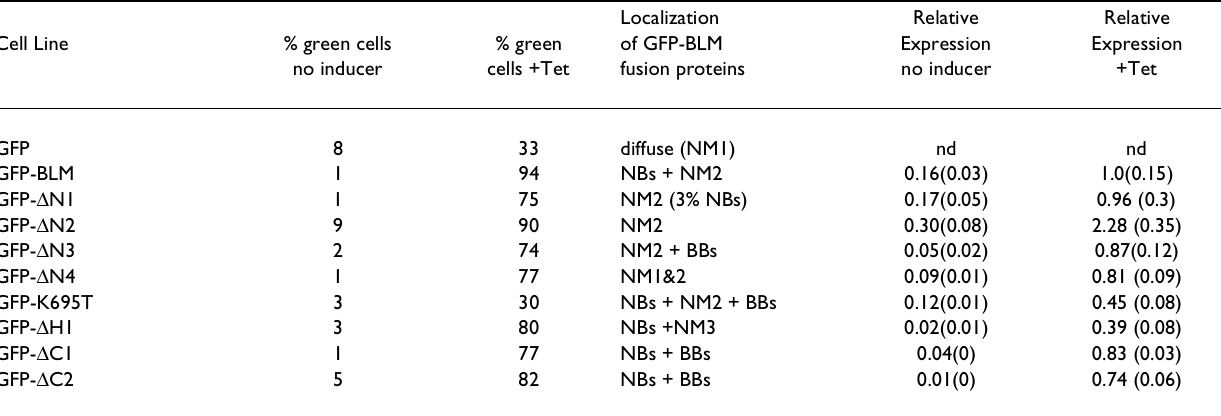
Table 1: Phenotypes of transfected cell lines expressing inducible GFP-BLM alleles. Localization Relative